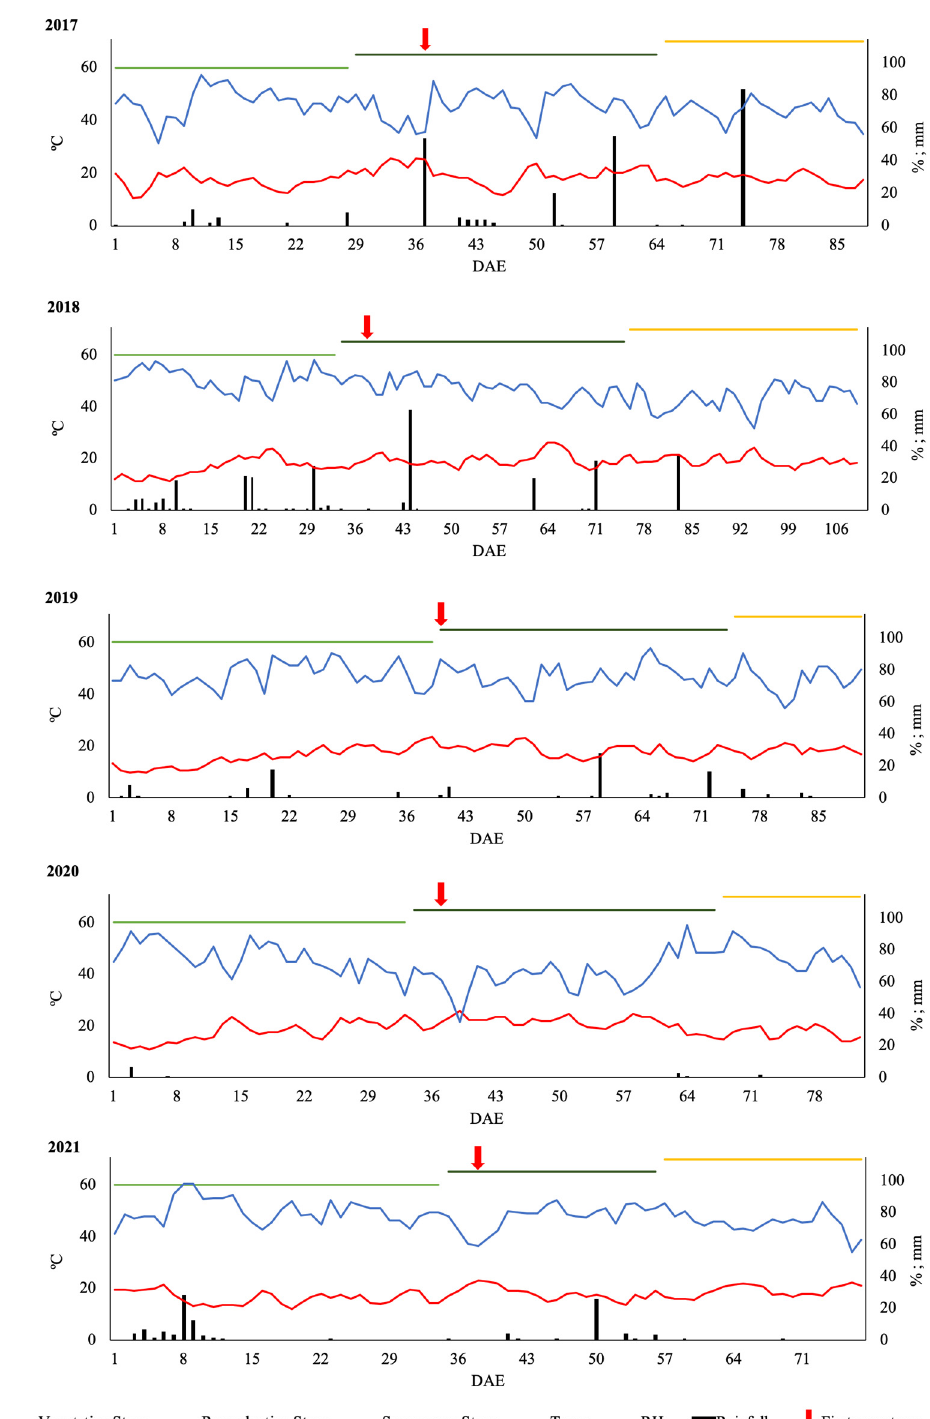
Figure 1. Evolution of weather parameters and phenology for the five crop seasons. Date of first symptoms is marked with arrows. DAE: days after emergence.